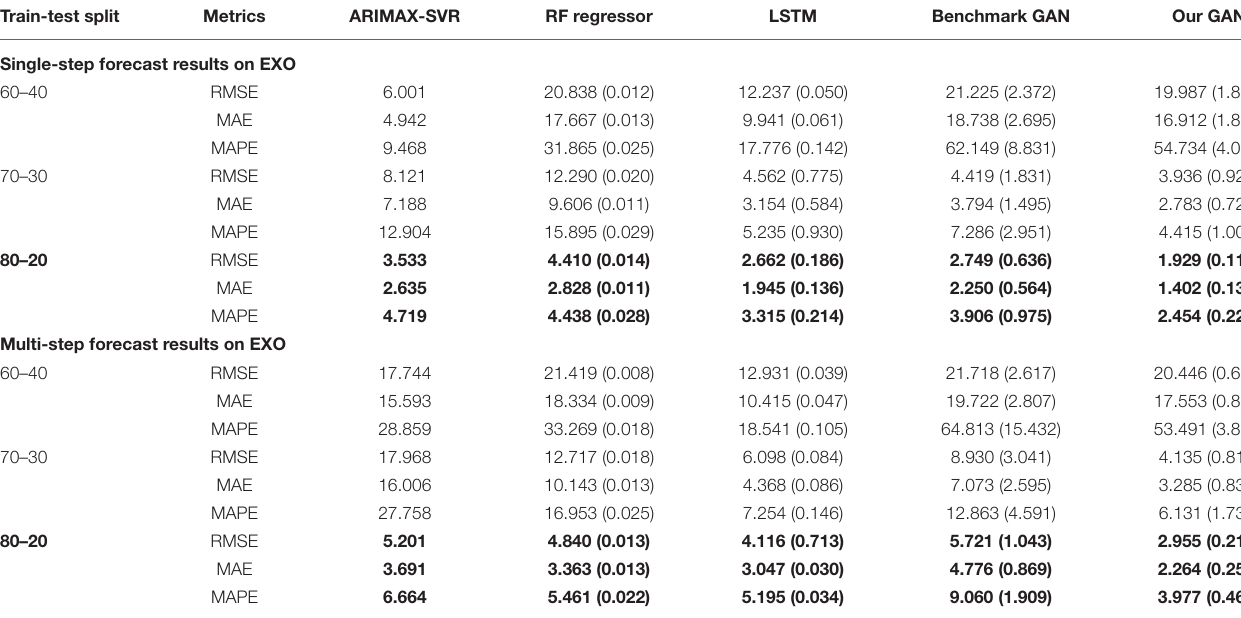
TABLE 6 | Train-test split results for one stock (EXO). Train-test split Our GAN